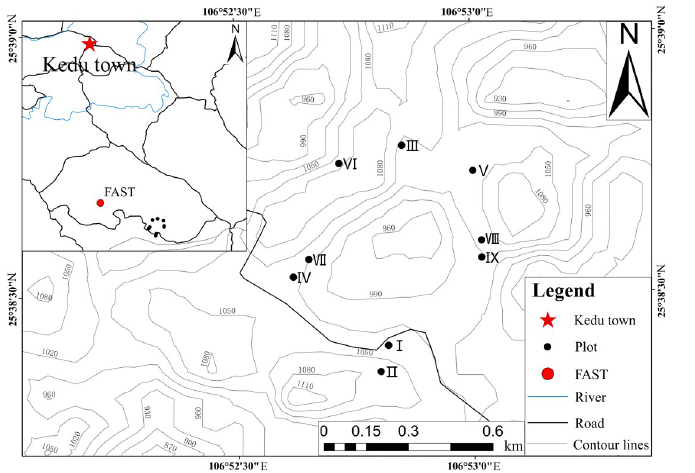
Fig 1. Location of sampling